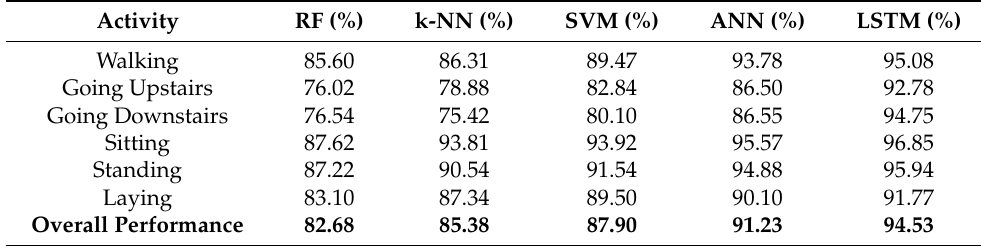
Table 1. Accuracy table of all the algorithms for each activity using 2-fold cross-validation.